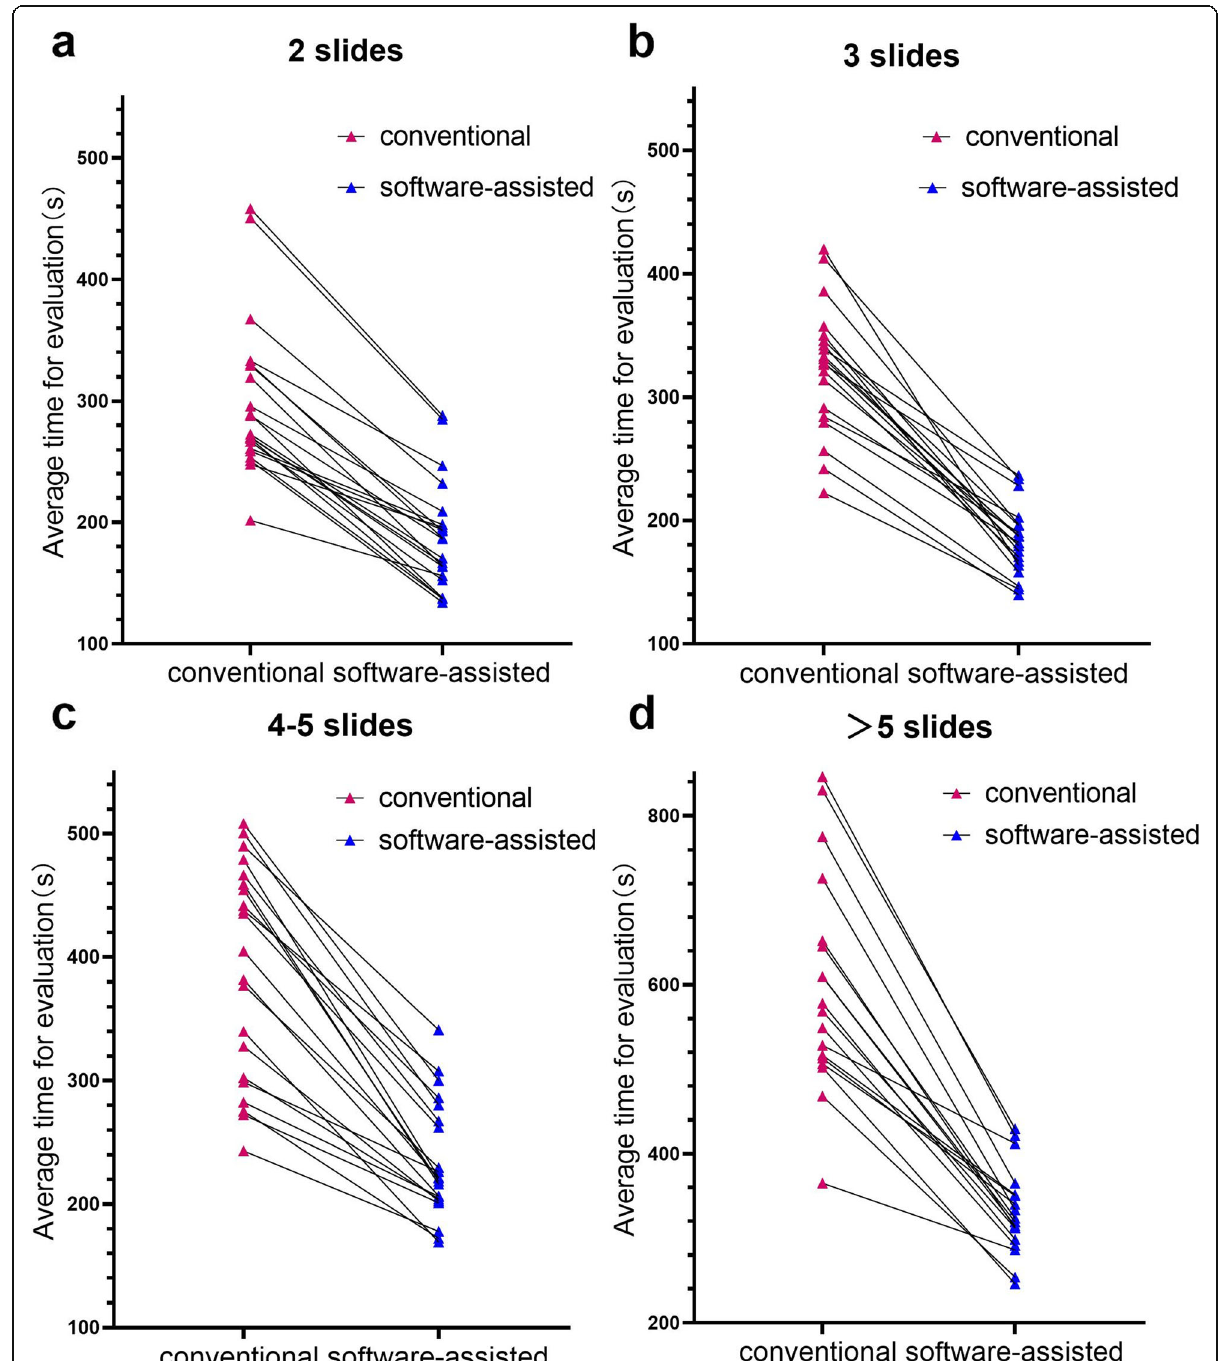
Fig. 4 Comparison of the average stitching time using conventional and software-assisted assessment of breast tumor bed. a , b , c , d respectively show that the number of slides on the largest section of the tumor bed after neoadjuvant chemotherapy is 2, 3, 4 – 5, and >